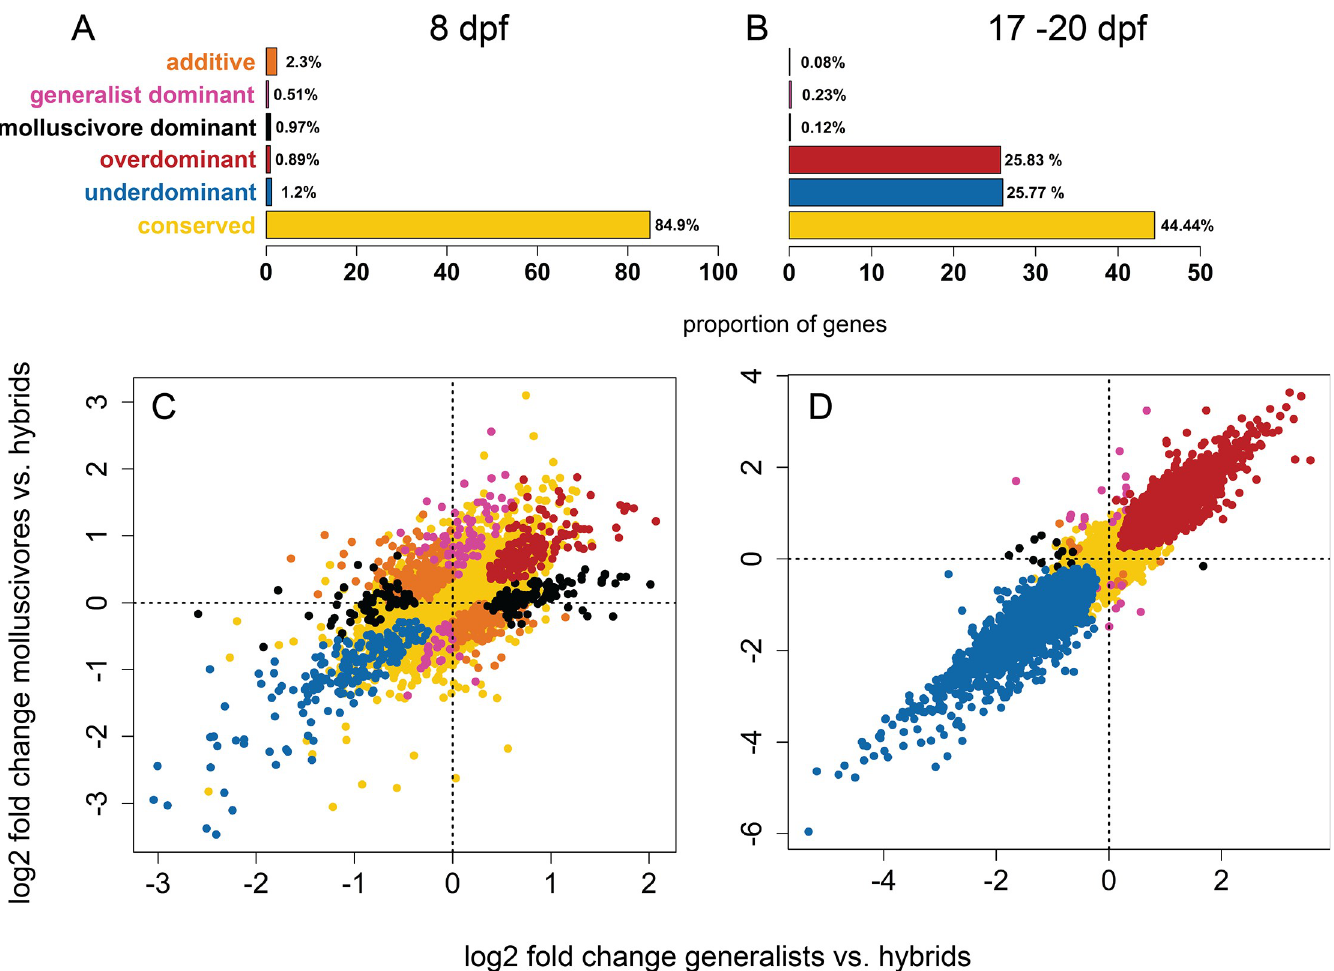
Fig 3. Gene expression inheritance in hybrids. The proportion of (A) 17,705 and (B) 12,769 genes showing each class of hybrid gene expression inheritance. Log2 fold changes in gene expression between molluscivores vs. hybrids on the y-axis and between generalists vs. hybrids on the x-axis for (C) whole-larvae sampled 8 days post fertilization (dpf) and (D) craniofacial tissues dissected from 17–20 dpf samples.